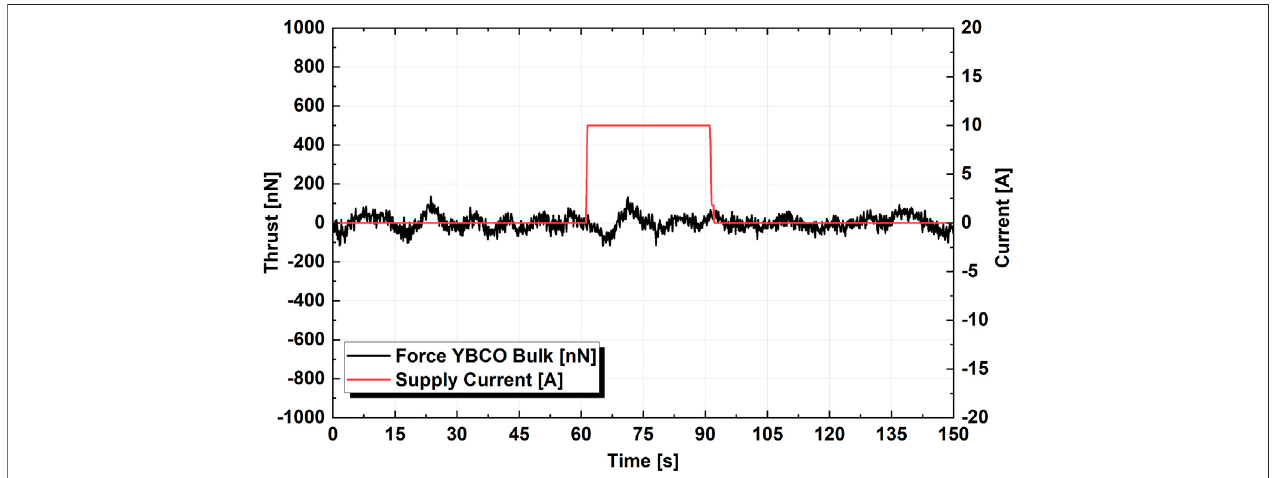
FIGURE 14 | Thrust measurement of the YBCO bulk at a maximum current of 10